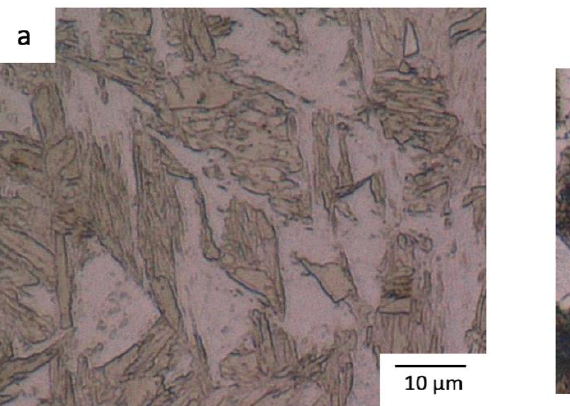
Figure 2. Optical and SEM micrographs of the samples after the heat treatments: ( a ) FM microstructure, ( b ) FP microstruc- ture, ( c ) detail of the martensite phase, ( d ) detail of the pearlite phase. In ( c ) and ( d ), the darker phase is ferrite . 3.2. Electrochemical Characterisation of the Passive Layer Potentiostatic polarisation at 0.2 V (vs. Ag/AgCl) is employed in 0.1 M NaOH envi- ronment for 6 h, ensuring the formation of a passive layer due to the alkaline environment. Figure 3 displays the change in current density with time during the potentiostatic polar- isation experiment. Initially, for the first seconds, the current densities j of both samples decrease exponentially due to the formation of a passive film layer. The current changes correspond to the growth of the passive layer. After the sharp decrease in the first few seconds, until around 100 s, the logarithmic slope ( - dlog| j | / dlog t ) of FM and FP samples has a value of 0.87 and 0.82, respectively, and decreases as the potentiostatic polarisation continues. A slope of 1 is associated with a perfect anodic passive film growth under a high electric field with negligible dissolution reactions of the oxide, where the entire cur- rent is consumed for the passive film growth [6–9]. In our case, the slopes of 0.87 and 0.82 indicate that part of the currents can be attributed to other processes. Then, it is assumed that initially, the passive layer grows homogeneously as a large part of the current is con- sumed for oxide growth, and other processes take place, such as the transformation of ferrous oxides into ferric oxides. The currents start stabilising after 6000 s for the FM sam- ple and after 8000 s for the FP sample.